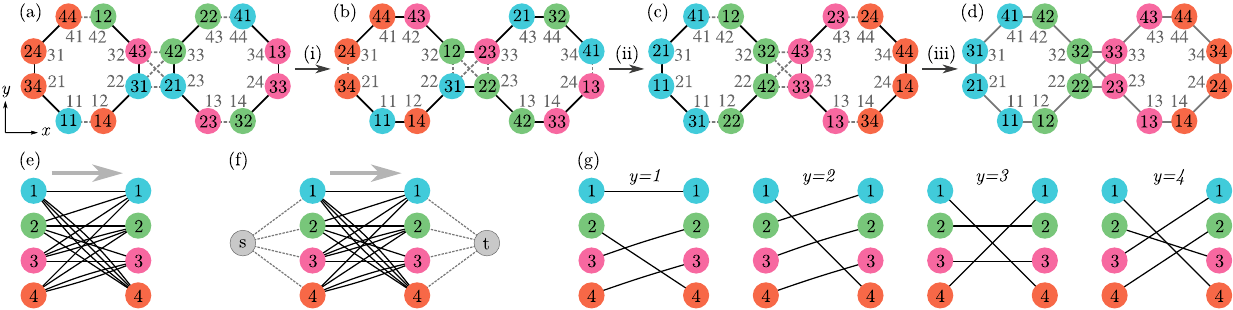
Fig. 8 Qubit permutation on proposed architecture with d x = 2, d y = 1, and m = 2. a – d Qubits (circles) labeled by their fi nal destination ( y , a x ) in the block are permuted using parallel neighbor sort along generalized (i) columns, (ii) rows, and (iii) columns as indicated by black solid as opposed to gray dashed lines. Gray labels next to the qubits index current qubit positions. e Bipartite graph corresponding to step (i). Nodes on the left and right indicate qubits with origin and fi nal destination in columns 1, 2, 3, and 4 respectively, while edges represent the corresponding qubit. f Same as e with virtual nodes s , t . g Matchings extracted from e . The y th matching determines qubits routed to position y . An edge ( l , r ) of y th matching indicates that a qubit of column l destined for column r is to be routed to position y